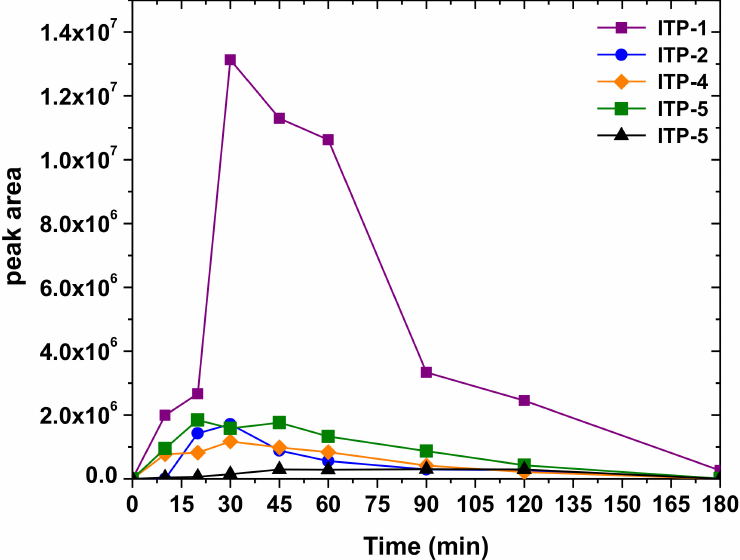
Figure 9. Evolution profiles of TPs generated from IBU by PEF/TiO 2 20 wt% under SSL,